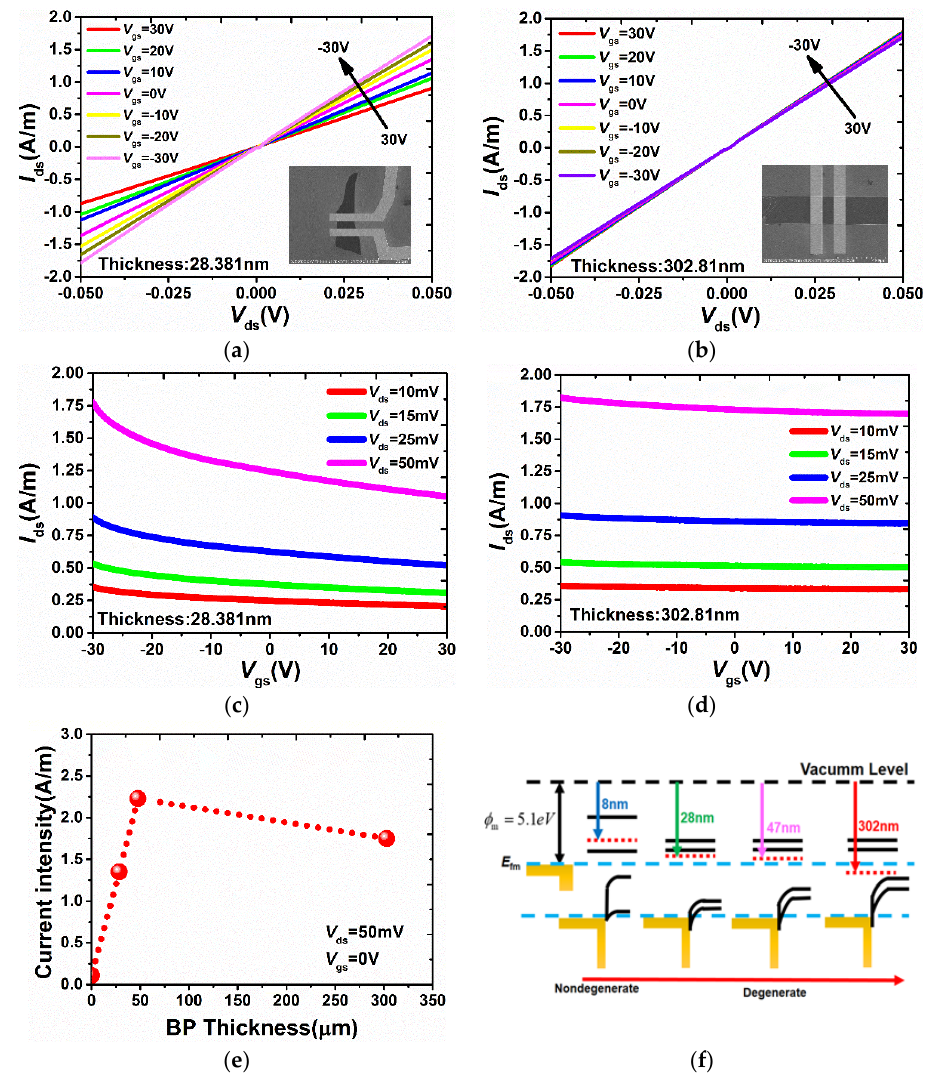
Figure 3. Output characteristics of BP FETs with ( a ) thickness of 28.381 nm and ( b ) with thickness of 302.81 nm. Inset: The SEM image of the same BP FETs. Transfer characteristics of BP FETs with ( c ) thickness of 28.381 nm and ( d ) thickness of 302.81 nm. ( e ) The current intensity as function of BP thickness. ( f ) Band diagrams for BP nanoflakes with different thicknesses.